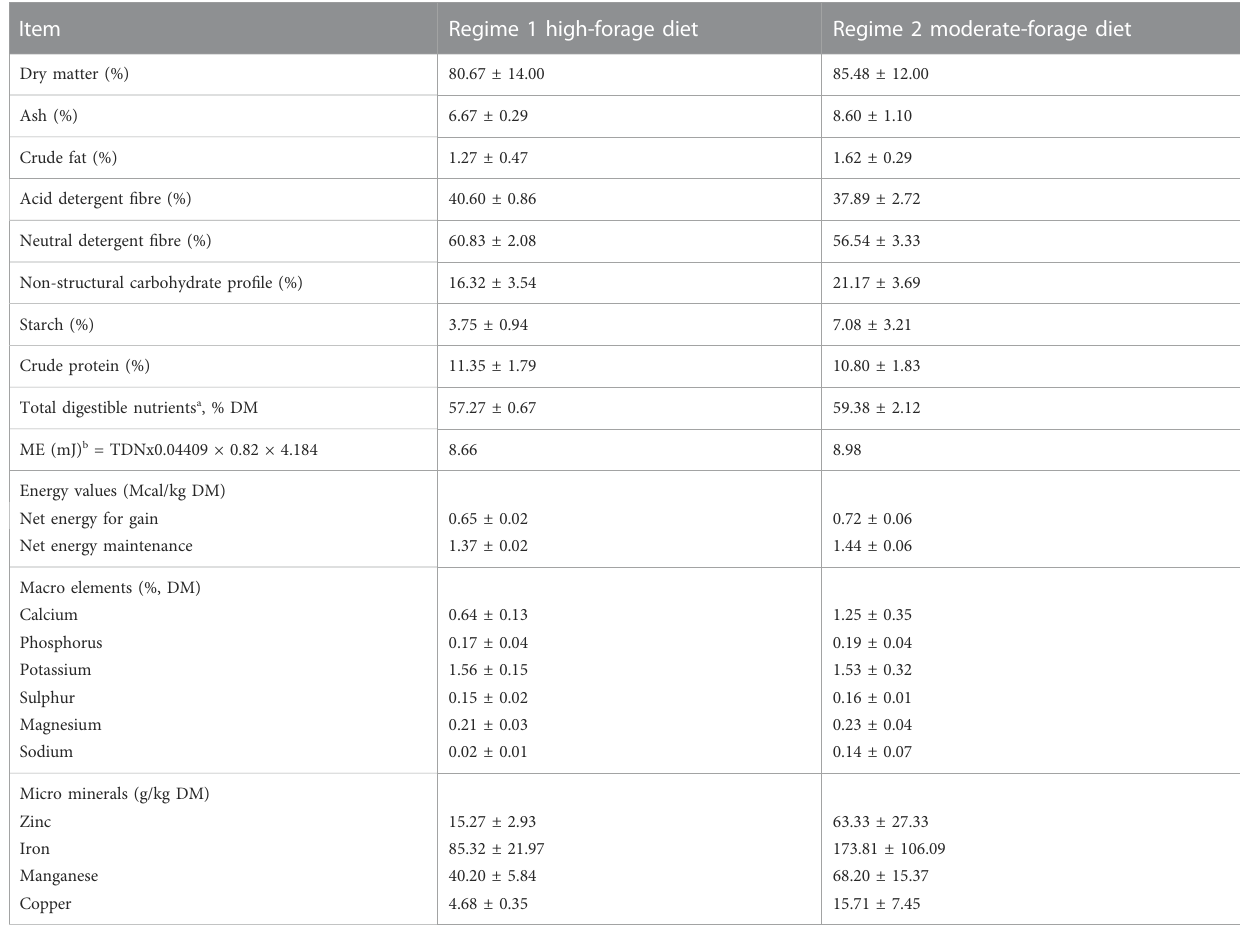
TABLE 1 Nutrient composition of diet fed to backgrounding steers during the Fall-Winter and Winter-Spring regimes over the 2 years of study.